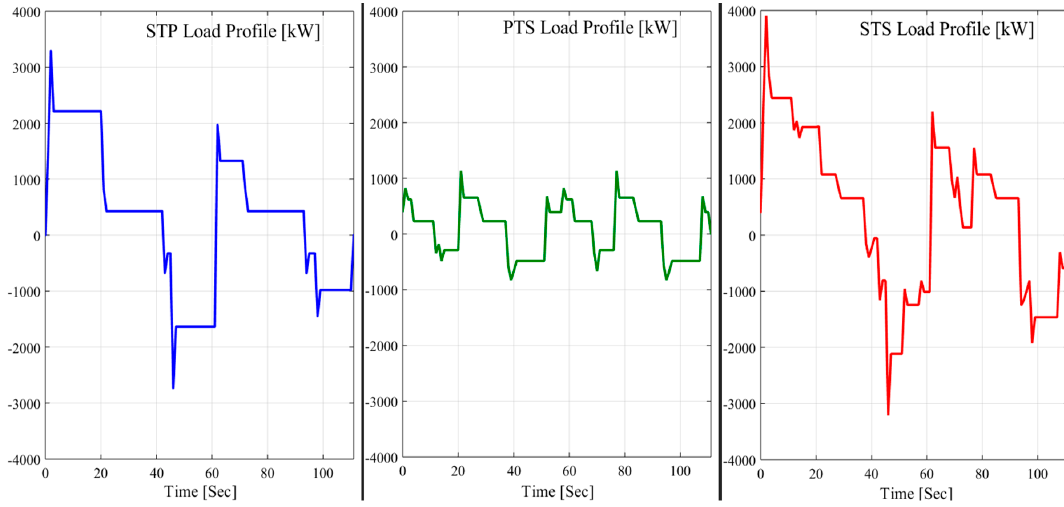
Figure 6. The reference load profile for the different part in an STS crane ( Dual Hoist operation).